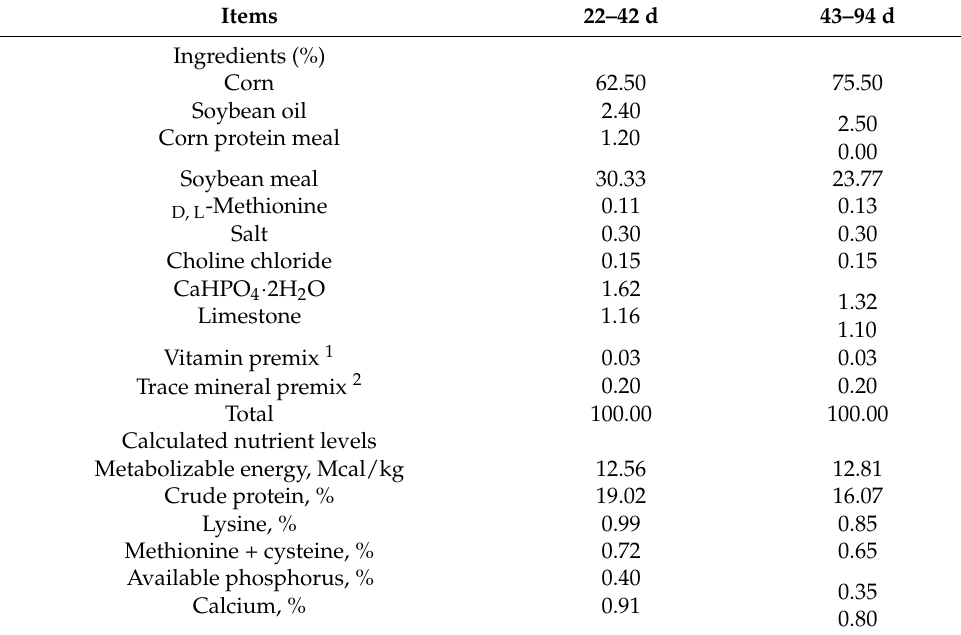
Table 1. Composition and nutrient levels of the basal